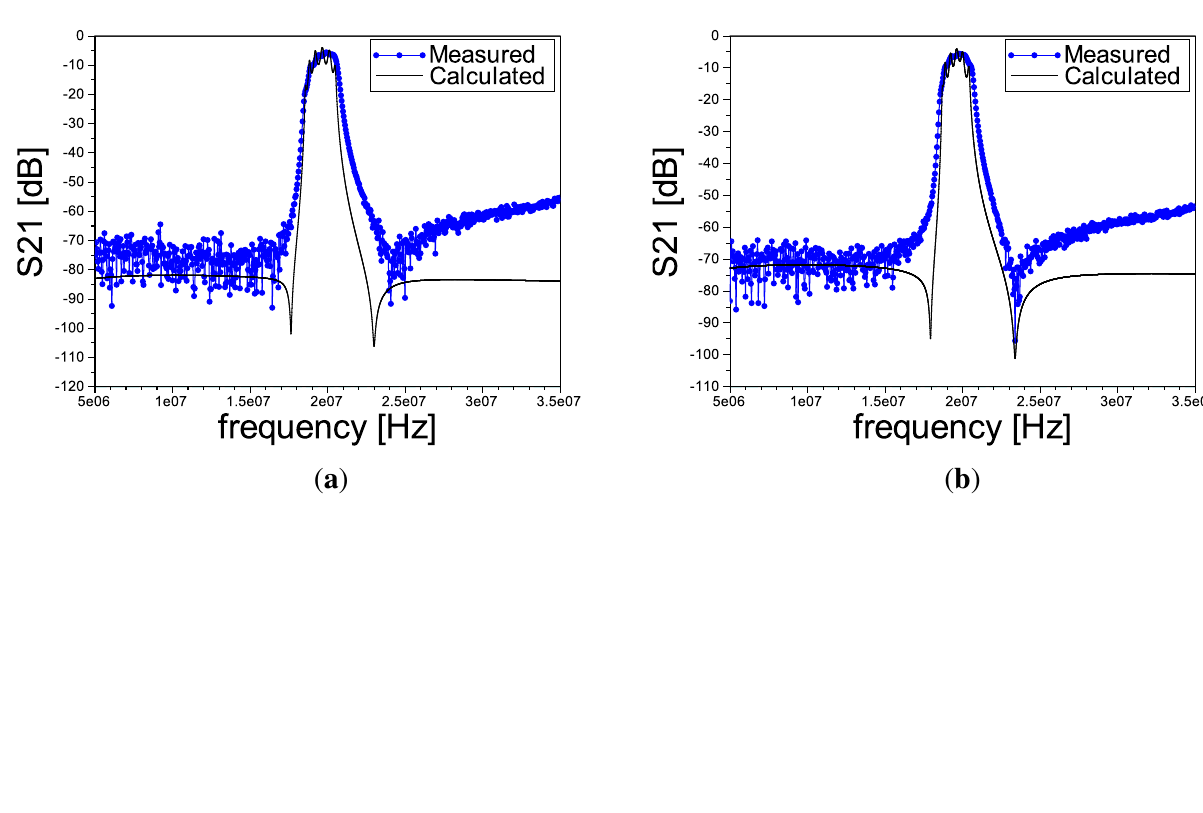
Figure 5. Measured and calculated transmission coefficient S